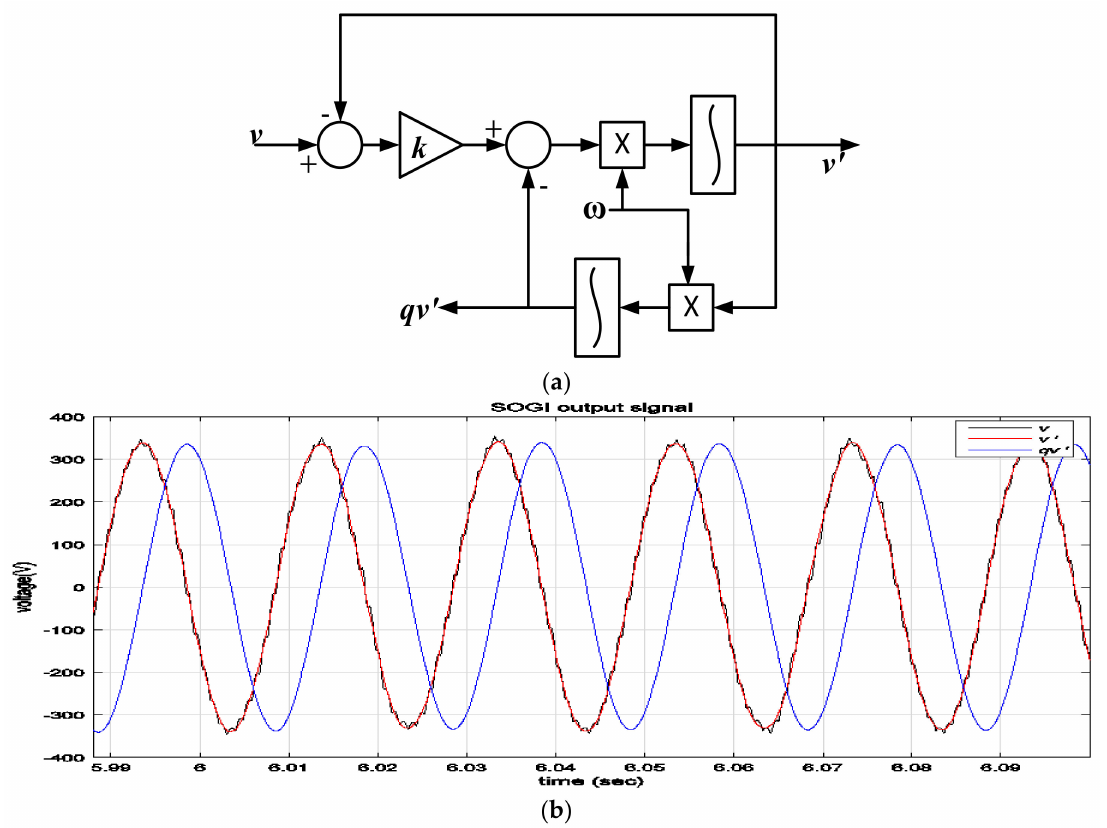
Figure 3. Second-order generalized integrator for voltage and frequency capture. ( a ) Control structure; ( b ) SOGI